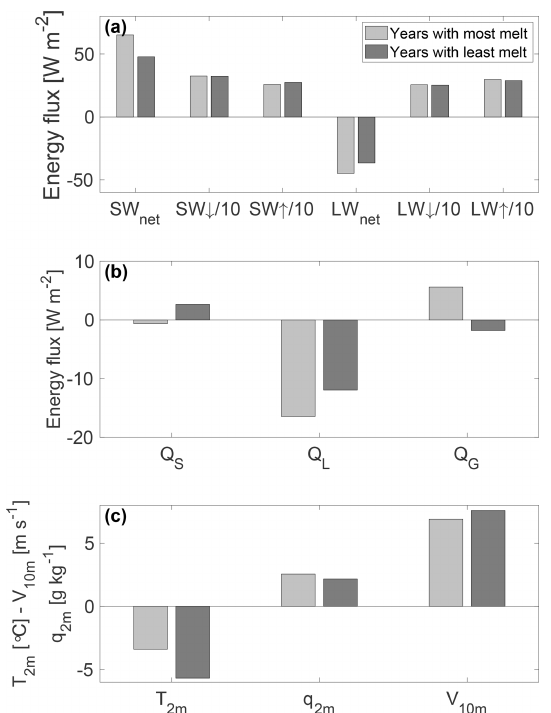
Figure 7. Average values of some SEB components (a, b) and some meteorological variables (c) for December and January in the years with the highest (2003–2004 and 2012–2013, in light grey) and low- est (1999–2000 and 2014–2015, in dark grey) amount of melt, as identified in Sect. 3.3. Note that SW ↓ , SW ↑ , LW ↓ and LW ↑ are scaled by a factor of 10 in panel (a) for